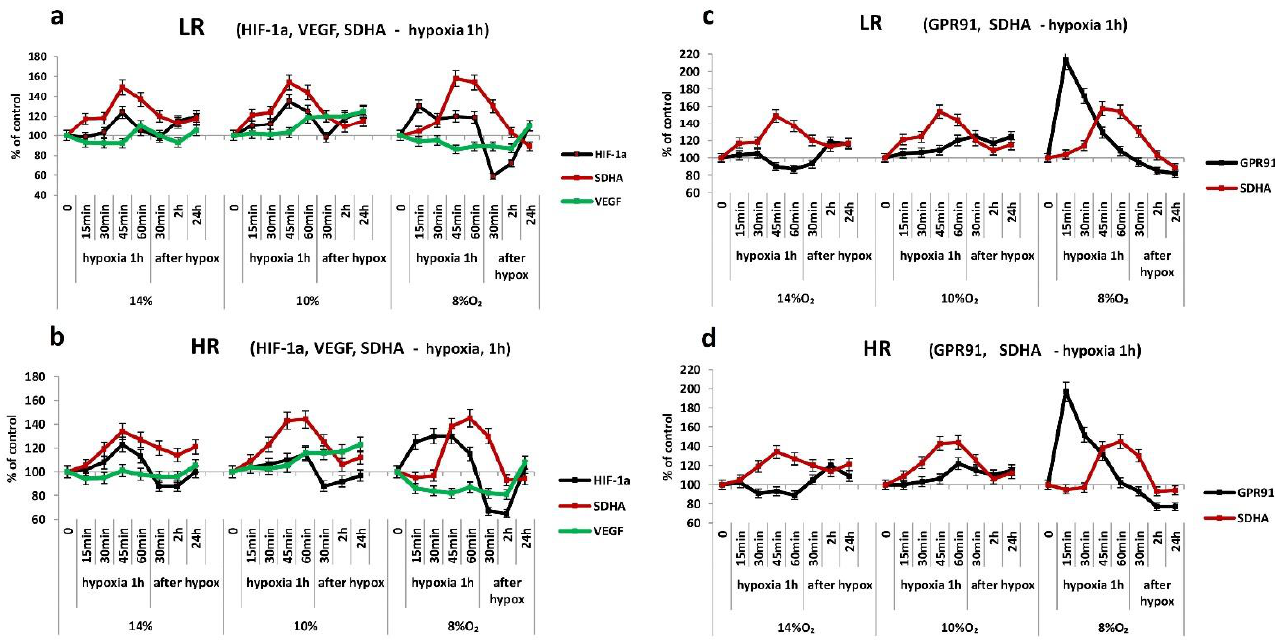
Figure 5. Dynamics of the expression of HIF1- α , VEGF, SDHA ( a , b ), GPR91 and SDHA ( c , d ) in LR and HR rat myocardium during a single 1-h hypoxic exposure (HBH, FiO 2 —14, 10, 8% O 2 ) and in the post-hypoxic period (For the rest, see Figure 2).